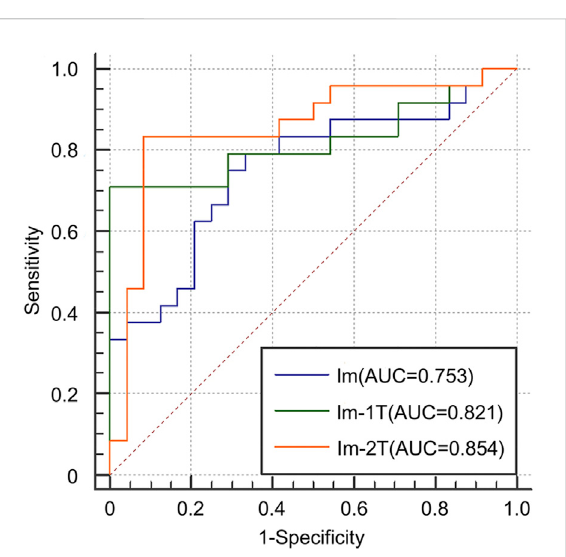
FIGURE 5 ROC curves for the Im, Im-1T, and Im-2T networks to show the effectiveness of two-stage transfer